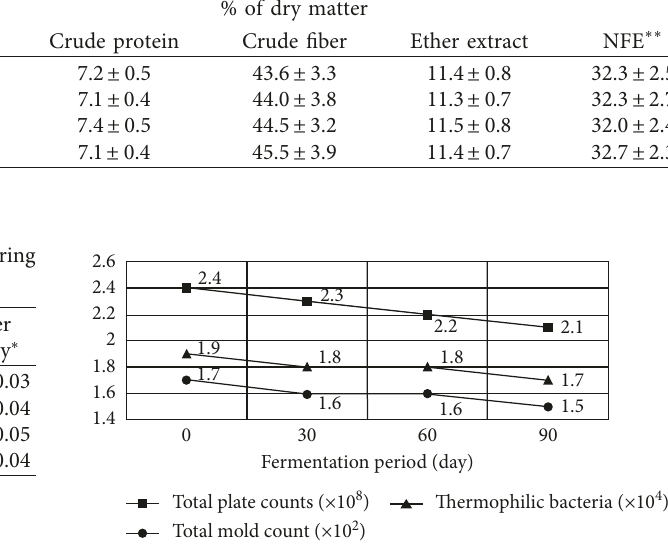
Figure 4: The total counts, the thermophilic bacteria, and the total mold count of olive cake during 90 days of fermentation.